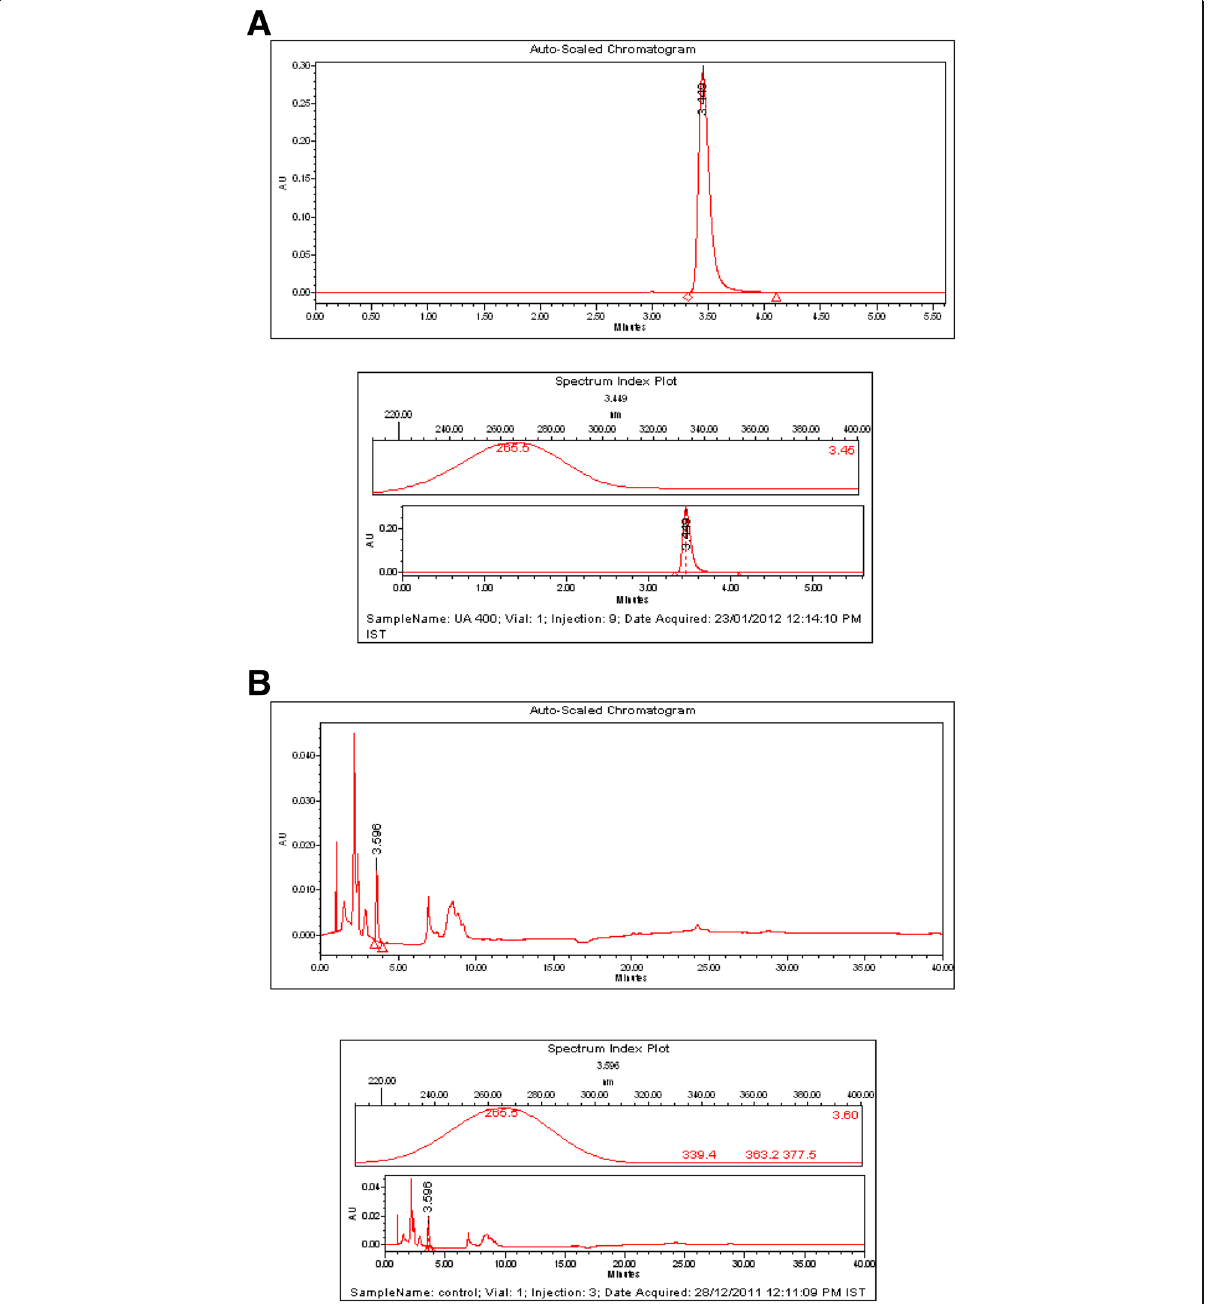
Fig. 2 a RP-HPLC chromatograms (photo-diode array detector set at 200 – 400 nm). Hippuric acid (HA) standard maximum absorption ( λ max) is at 265.5 nm and Retention time is 3.4 min. b RP-HPLC chromatograms (PDA detector set at 200 – 500 nm). Hippuric acid (HA) analysis from MEAE treated albino Wistar rat urine sample. Maximum absorption ( λ max) is at 265.5 nm and Retention time is at 3.5